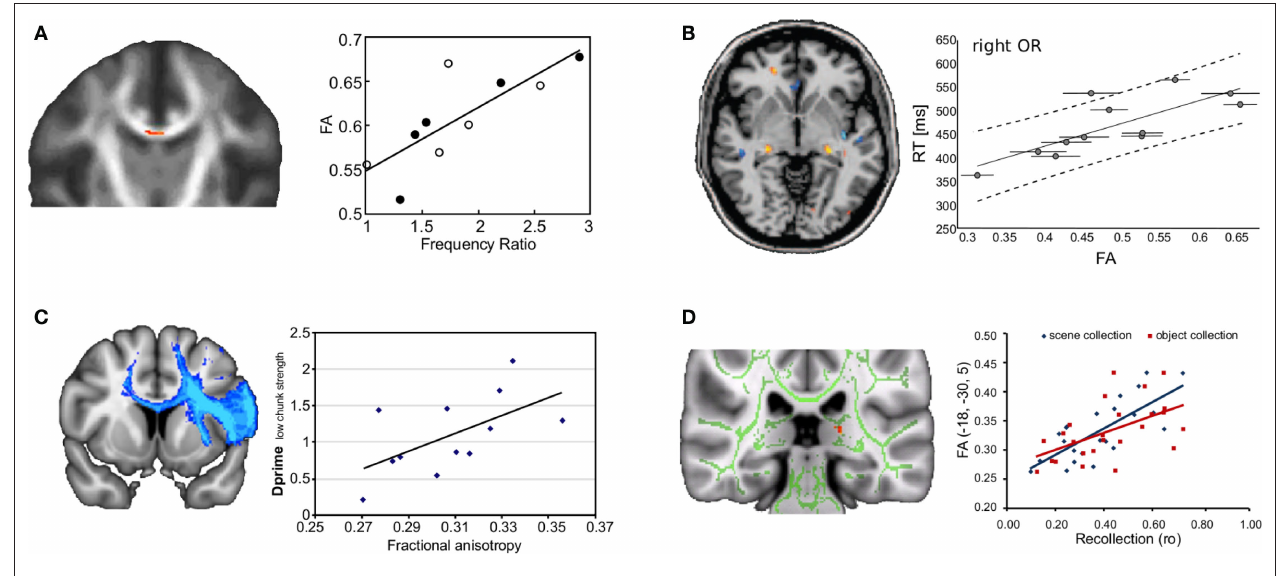
FIguRe 4 | Relationship between fractional anisotropy (FA) and behavioral indices for a range of different tasks. Brain images show voxels where a significant correlation was found. Scatter plots illustrate spread of behavioral and fractional anisotropy values across subjects. (A) Individuals with higher callosal fractional anisotropy performed better at an asynchronous bimanual finger-tapping task (closed circles represent males, open circles females). (B) Counter-intuitively, individuals with higher fractional anisotropy in the right optic radiation (OR) performed worse on a choice reaction time task